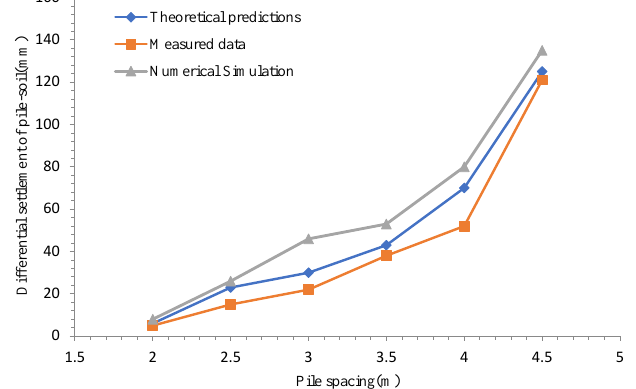
Figure 21. Comparison of numerical simulation, theoretical predictions, and monitoring data of differential settlement of pile soil with different pile spacings.